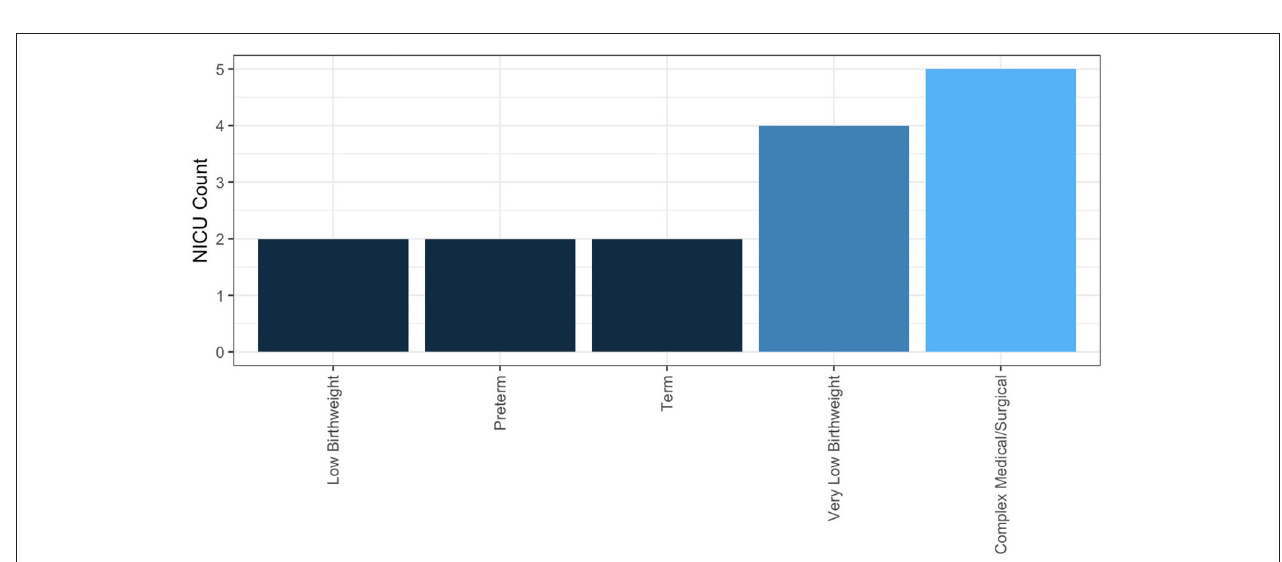
FIGURE 5 | Human milk analysis responsibilities in NICUs. Who performs HMA and who establishes quality of measurements.